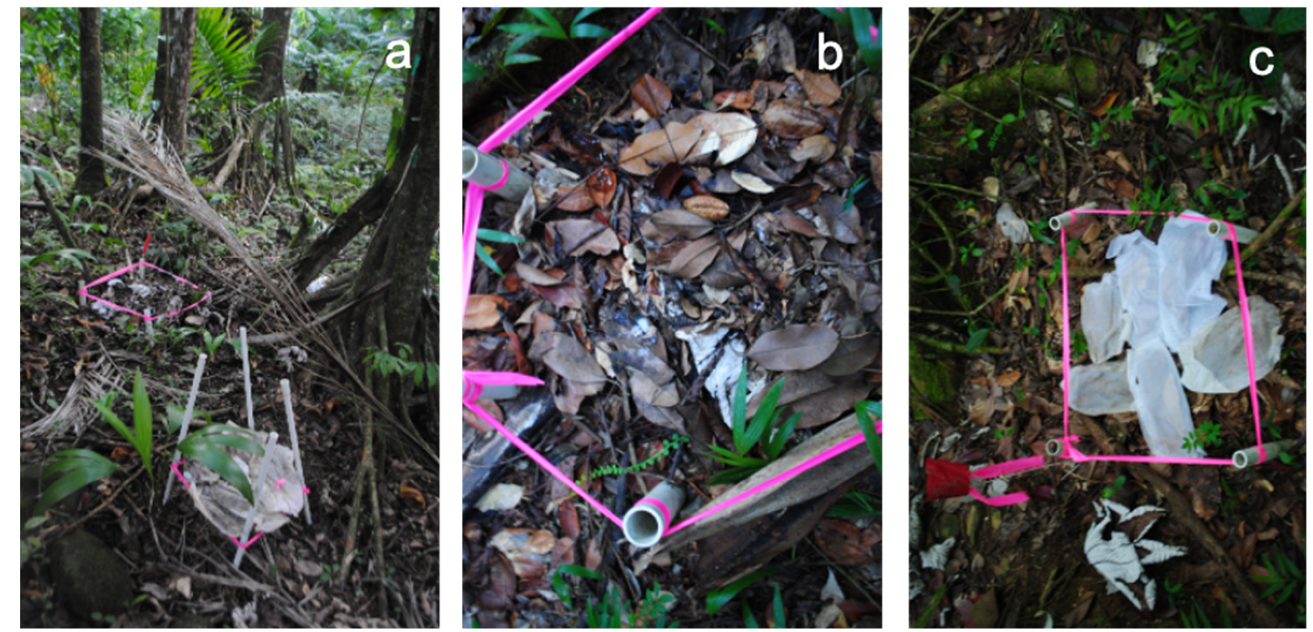
Figure 1. ( a ) Preconditioning of M. bidentata leaves suspended in baskets 10 cm above the forest floor. ( b ) Litter mat formed by basidiomycete mycelium, Gymnopus johnstonii . ( c ) Leaves in mesh bags placed on G. johnstonii litter mat. (Photos by S. Bibbo).